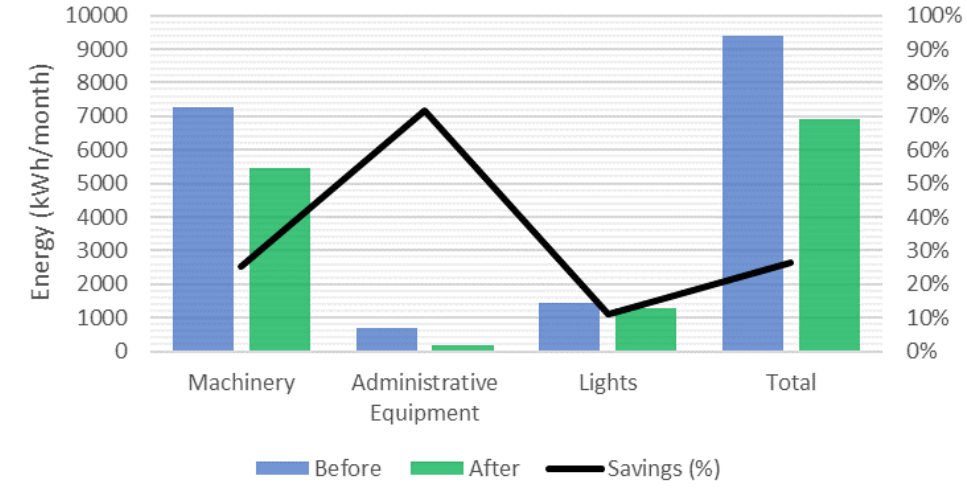
Figure 7. Analysis of energy efficiency